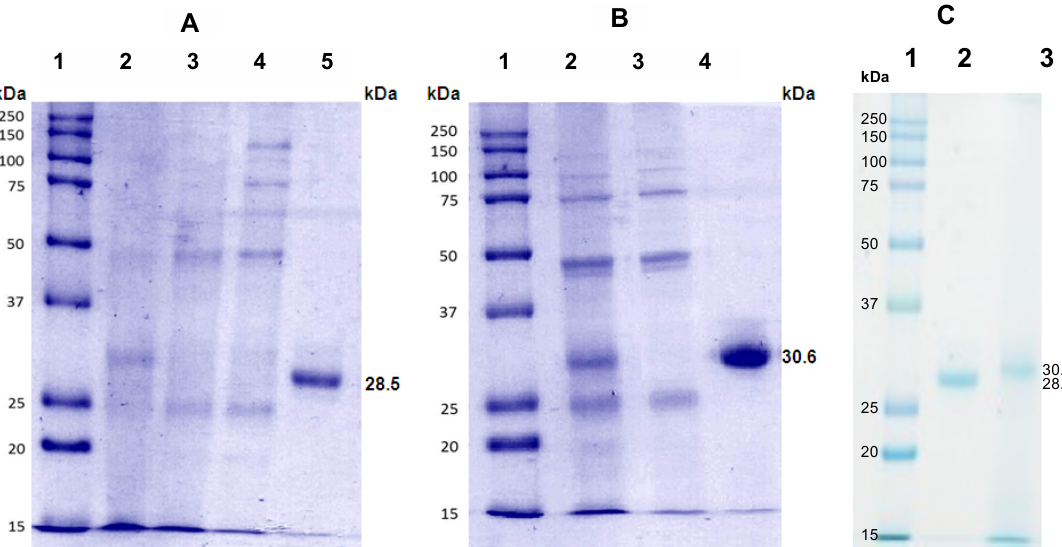
Figure 2. Polyacrylamide gel electrophoresis (SDS-PAGE) of the purification steps of the lectins of the two varieties of Phaseolus coccineus . ( A ) Black variety, (1) molecular weight marker, (2) protein extract, (3) fraction retained on the chromatographic column, (4) fraction not retained on the chromatographic column, (5) purified ABBL. ( B ) Purple variety (1) molecular mass markers, (2) protein extract, (3) fraction not retained on the chromatographic column, (4) purified ABPL. ( C ) Purified lectins (1) molecular weight marker, (2) purified ABBL, (3) purified ABPL.